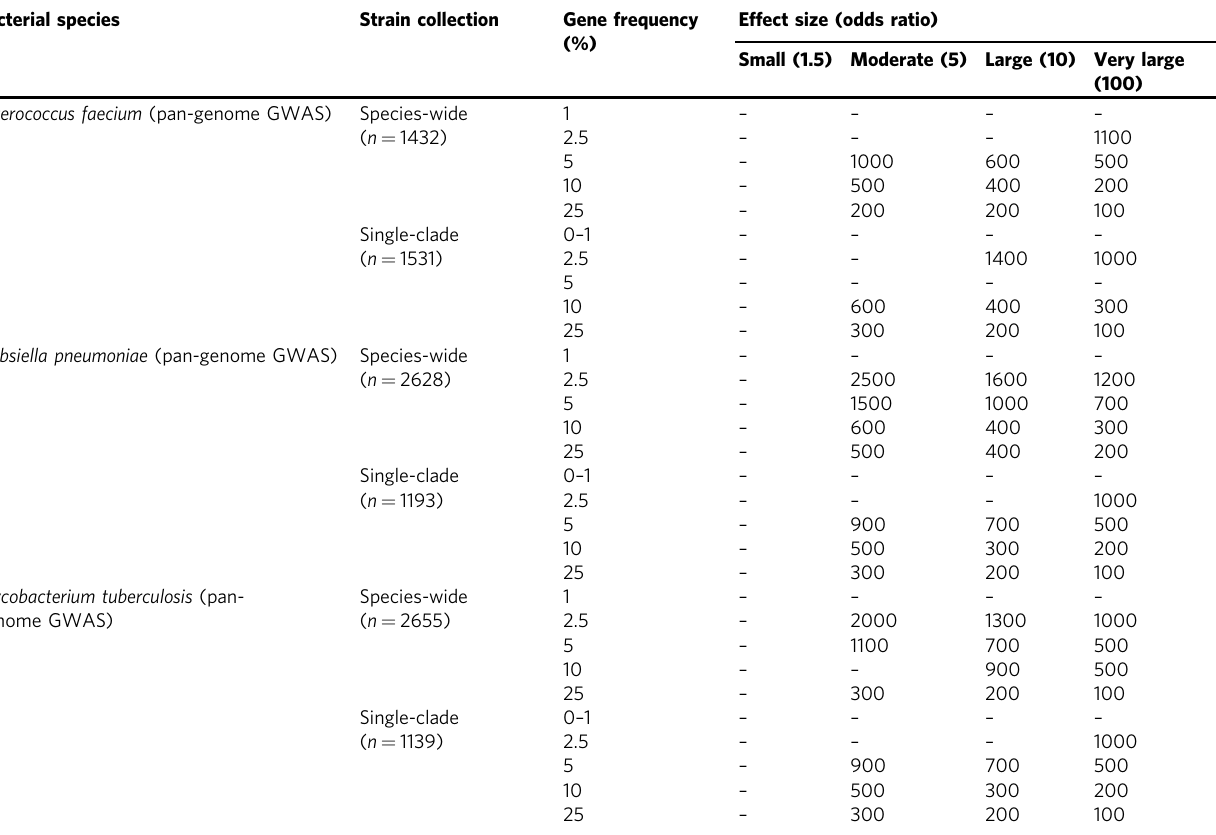
Table 2 Sample sizes required to detect causal genes of different MAF and effect sizes in a pan-genome GWAS. Bacterial